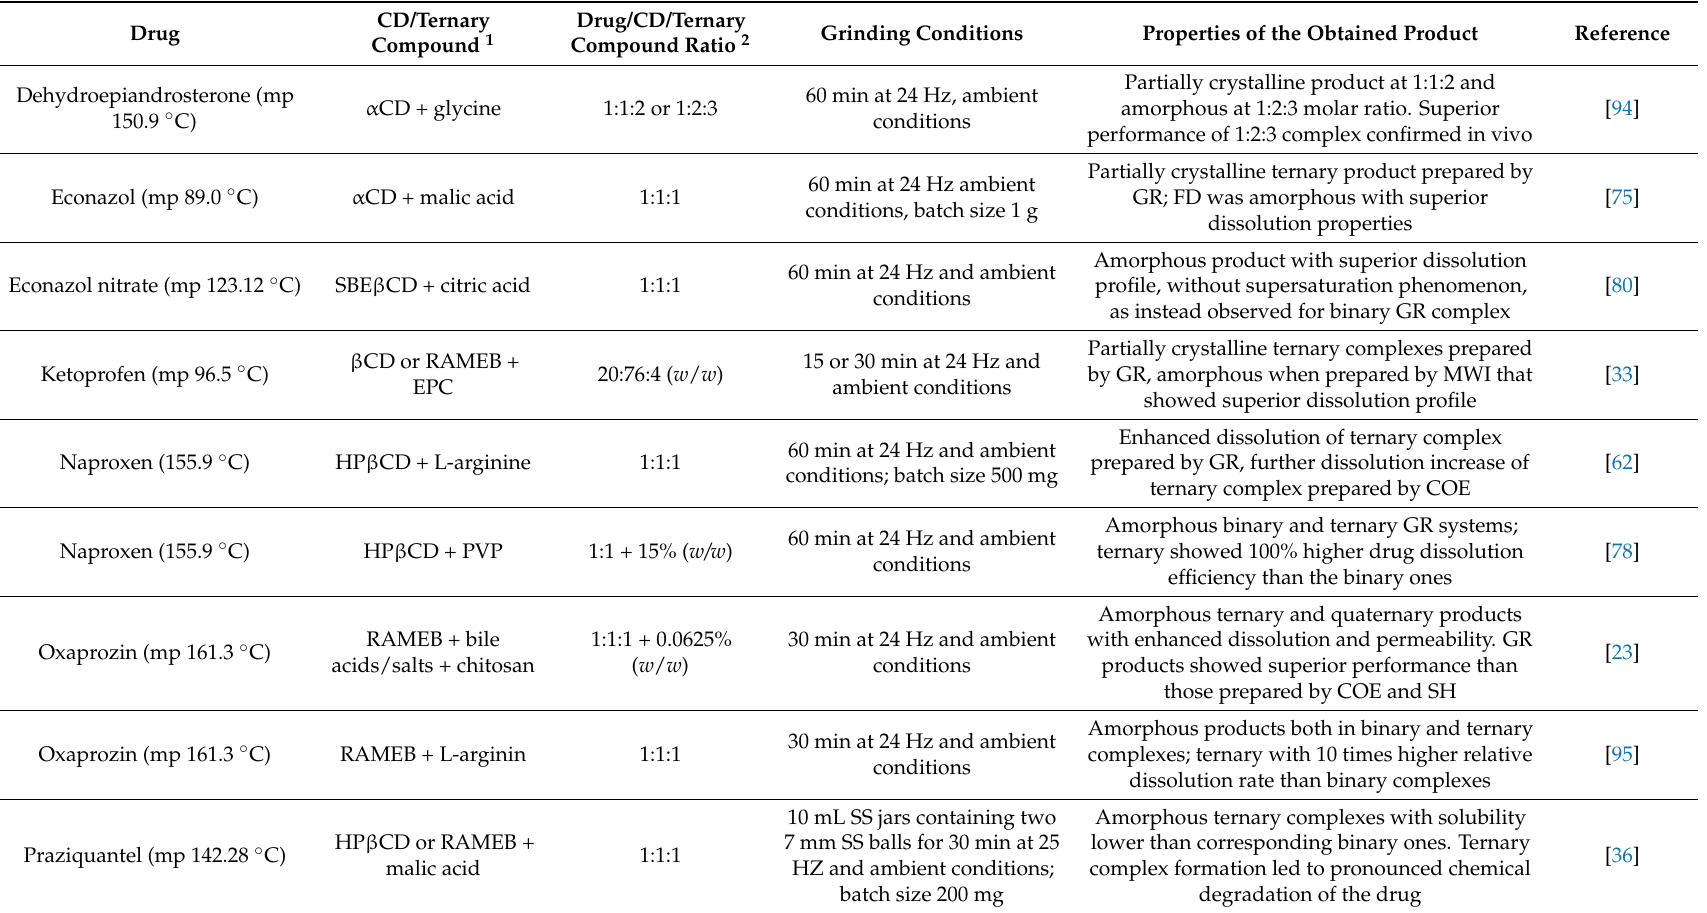
Table 3. An overview of ternary drug/CD complexes prepared by grinding using high-energy vibrational